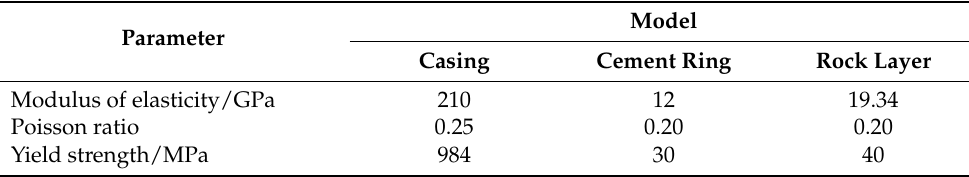
Model Casing Cement Ring Rock Layer